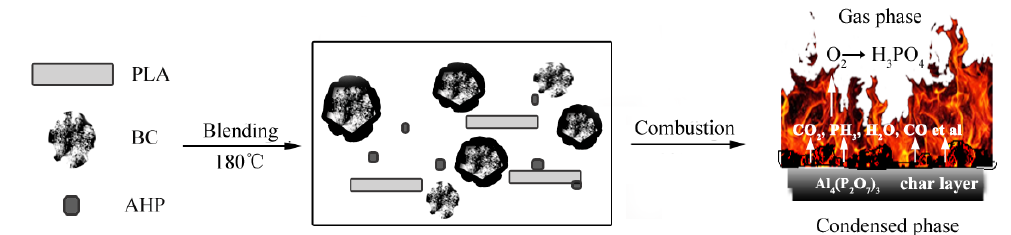
Figure 8. Schematic representation of the flame-retardant mechanism of BC / PLA / AHP during combustion.